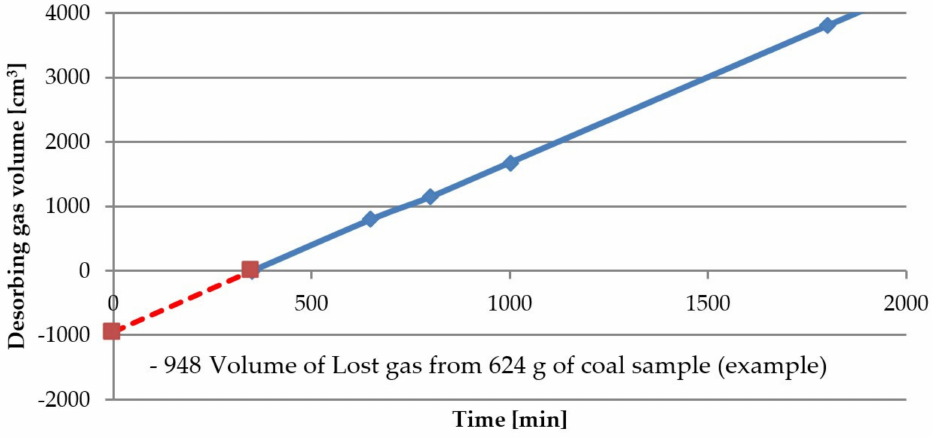
Figure 4. Lost gas volume determination in the USBM